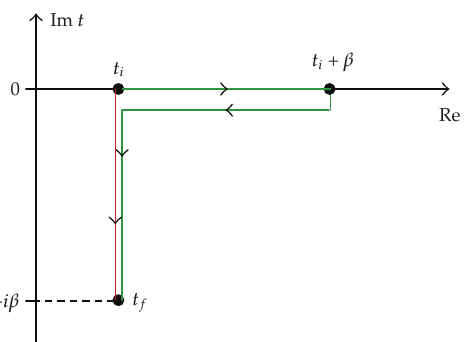
Figure 2: Integration contour in the complex time plane for the imaginary time (cid:2) red (cid:3) and the Schwinger- Keldysh (cid:2) green (cid:3) formalism for finite temperature field